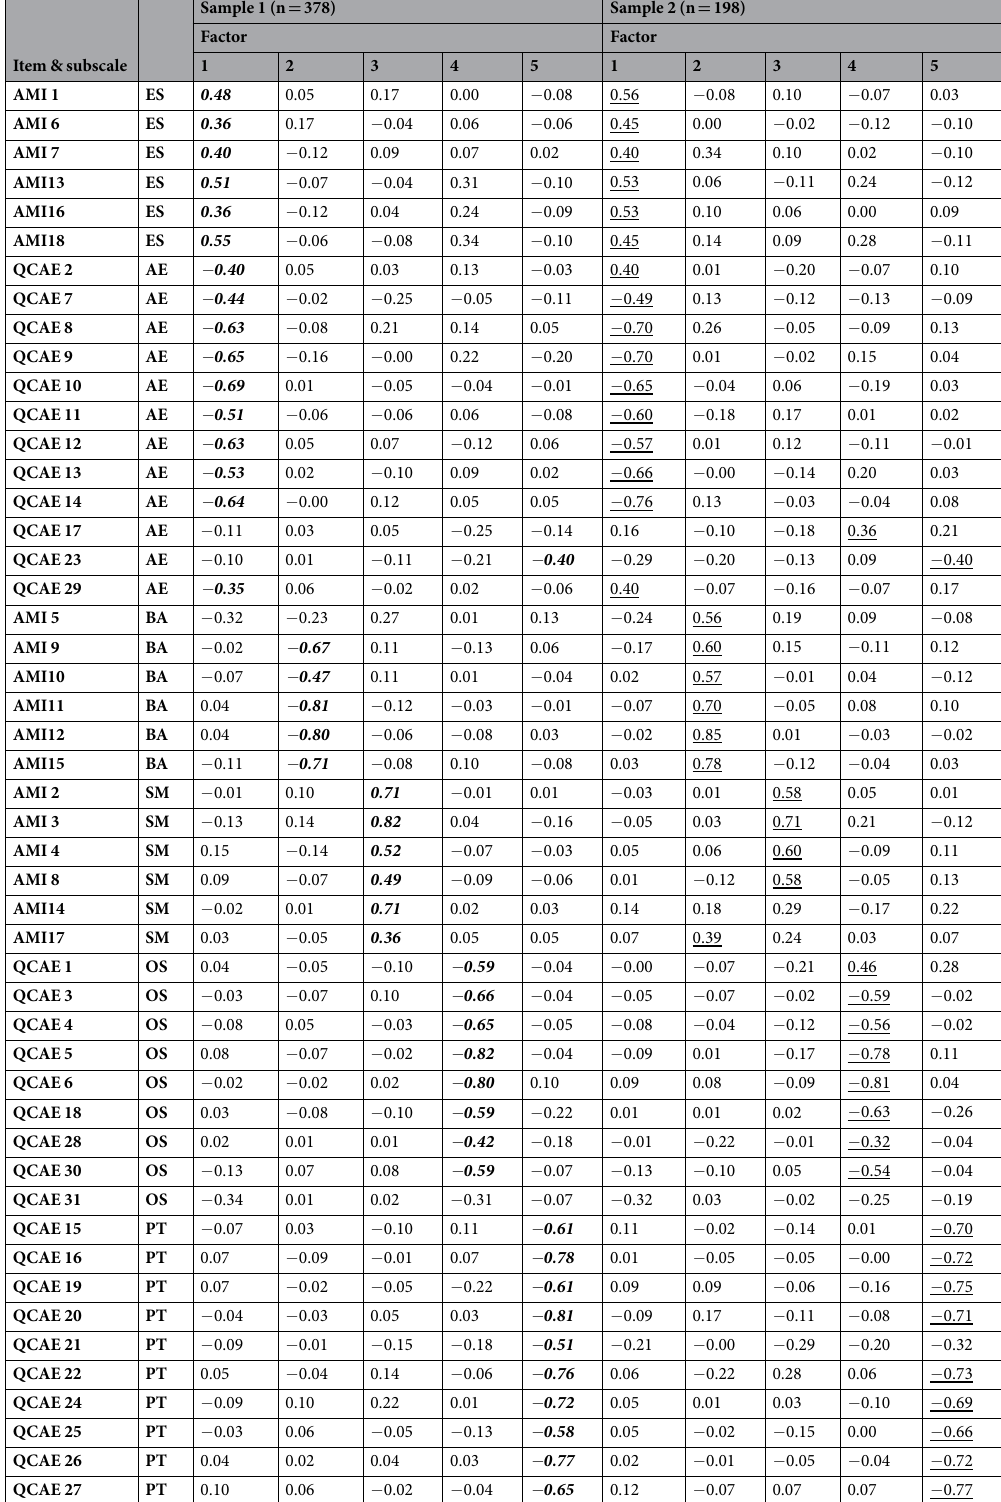
Table 1. Item loadings support a 5-factor structure of items related to empathy and apathy-motivation. The AMI (Apathy-Motivation Index) is an 18-item self-report measure of apathy that comprises three subscales: (1) ES: emotional sensitivity (emotional apathy, as all items reverse scored), (2) SM: social motivation (social apathy, as all items reverse scored), and (3) BA: behavioural activation (behavioural apathy, as all items reverse scored). The QCAE (Questionnaire of Cognitive and Affective Empathy) is a 31-item self-report measure of empathy. It contains two main subscales (1) AE: affective empathy, and (2) cognitive empathy that may be further subdivided into either (2a) OS: online simulation, or (2b) PT: perspective taking. Items with